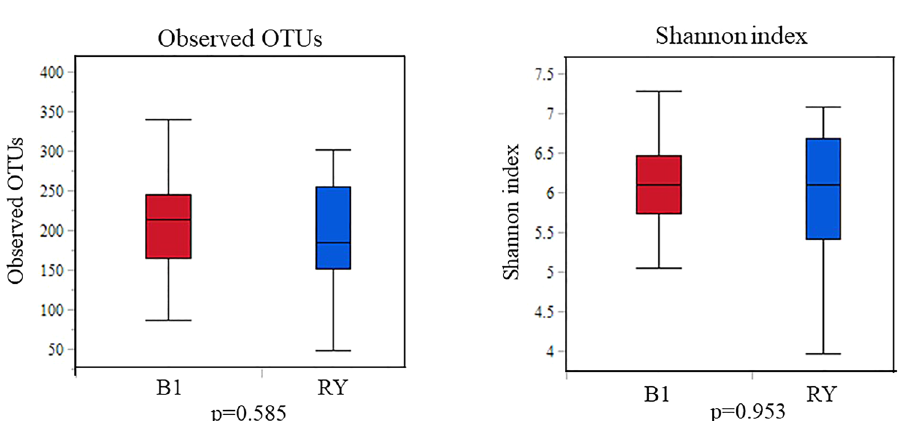
Figure 7. Alpha diversity of the gastric microbiota between Billroth I (BI) and Roux-en-Y (RY) reconstruction. Operational taxonomic unit and Shannon indices of the gastric microbiota after BI compared with RY reconstruction. P-values from the Kruskal–Wallis test are